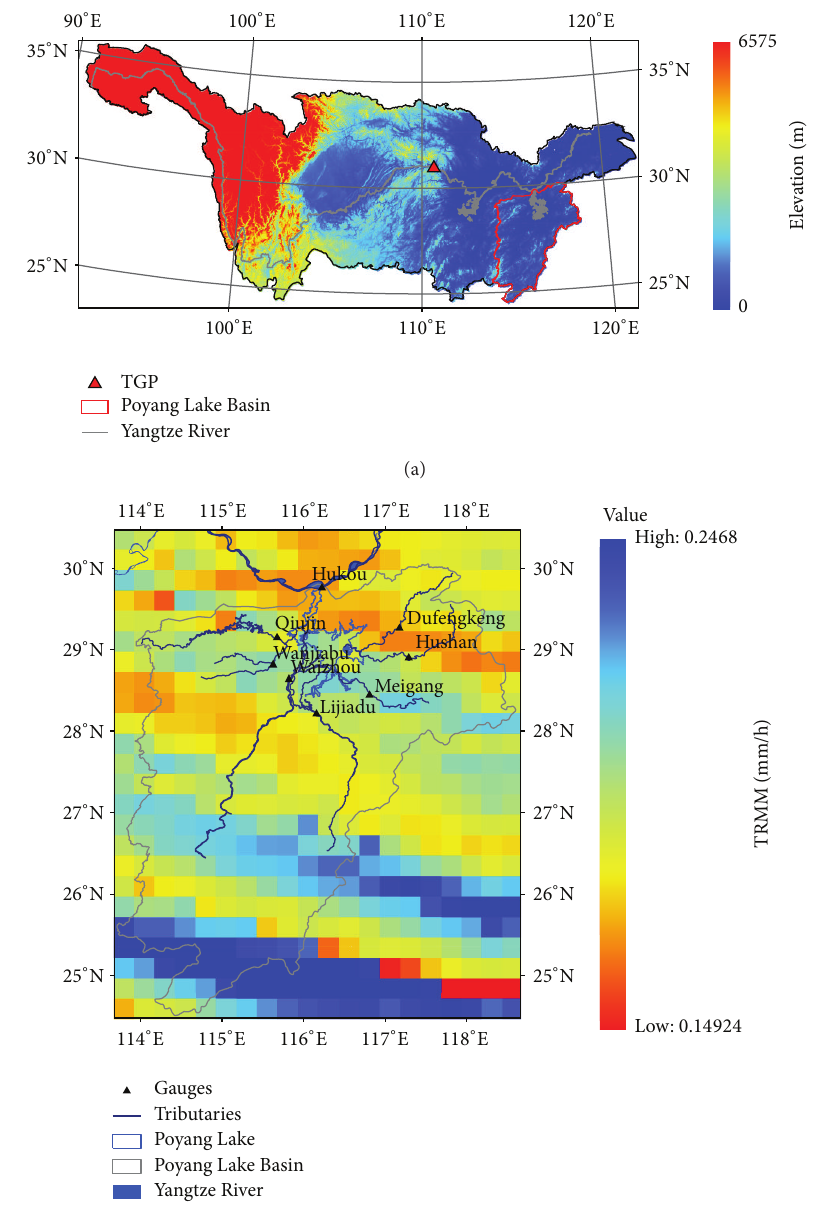
Figure 1: Study area maps. (a) Locations of the TGP and Poyang Lake Basin in the Yangtze River basin; the red triangle is the TGP and the background is SRTM DEM. (b) Major tributaries and gauges in the basin; the average TRMM precipitation during 1998–2012 is shown as background. The black triangles and blue lines annotate the hydrologic stations in the lake and its main tributaries,